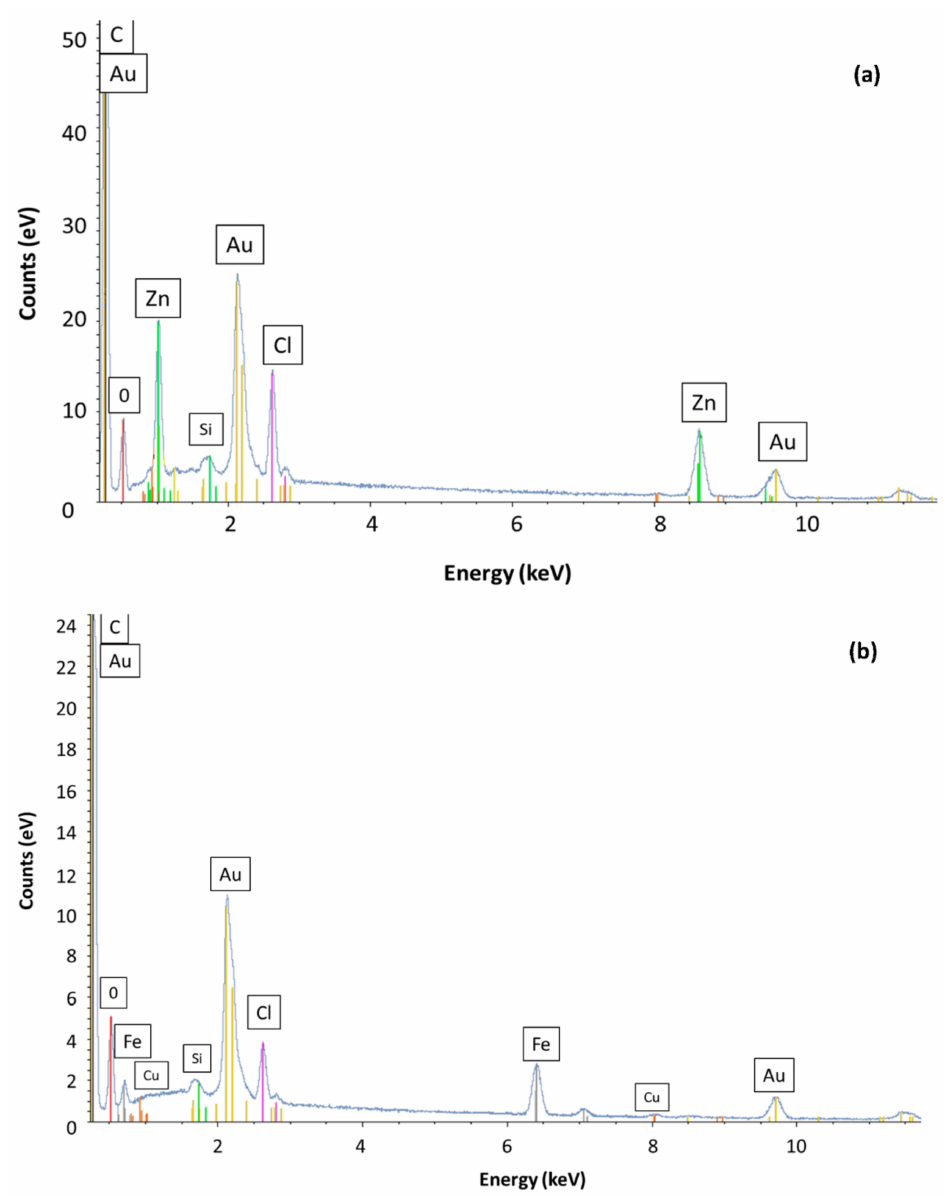
Figure 3. EDS spectra of ( a ), AC; ( b ), AC-Fe. A focus on the measured EDS area is presented in Figure